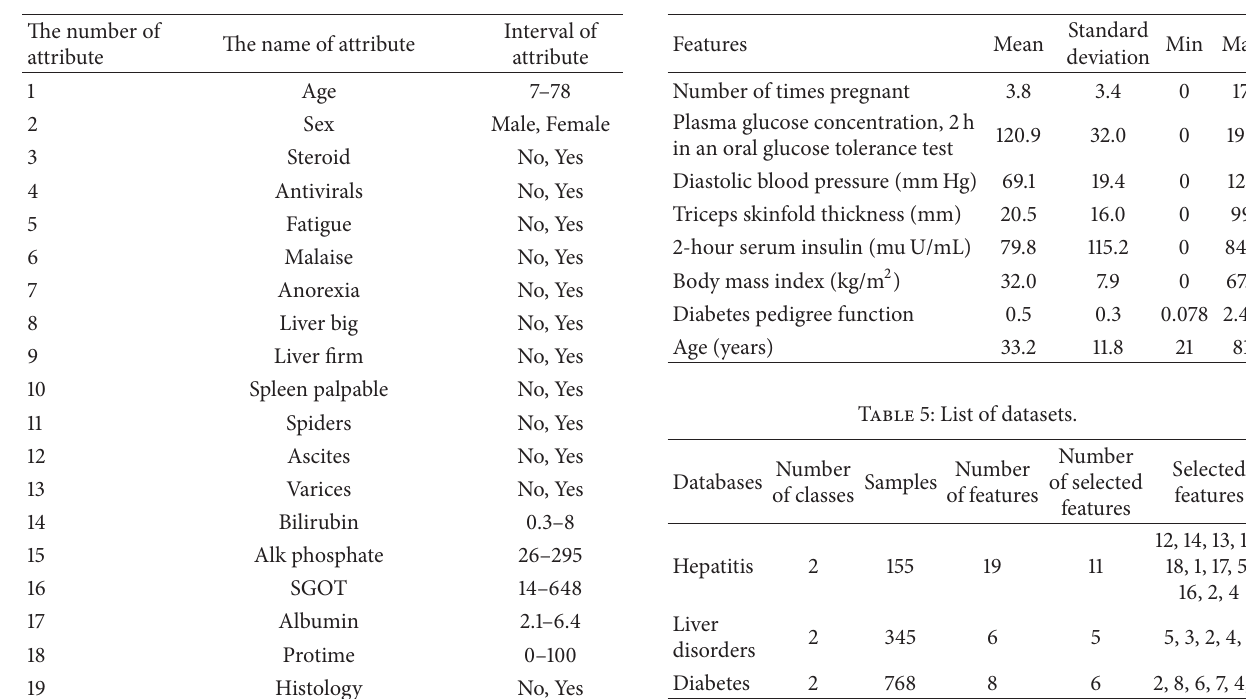
Table 2: Range values and attribute names for hepatitis dataset [35].